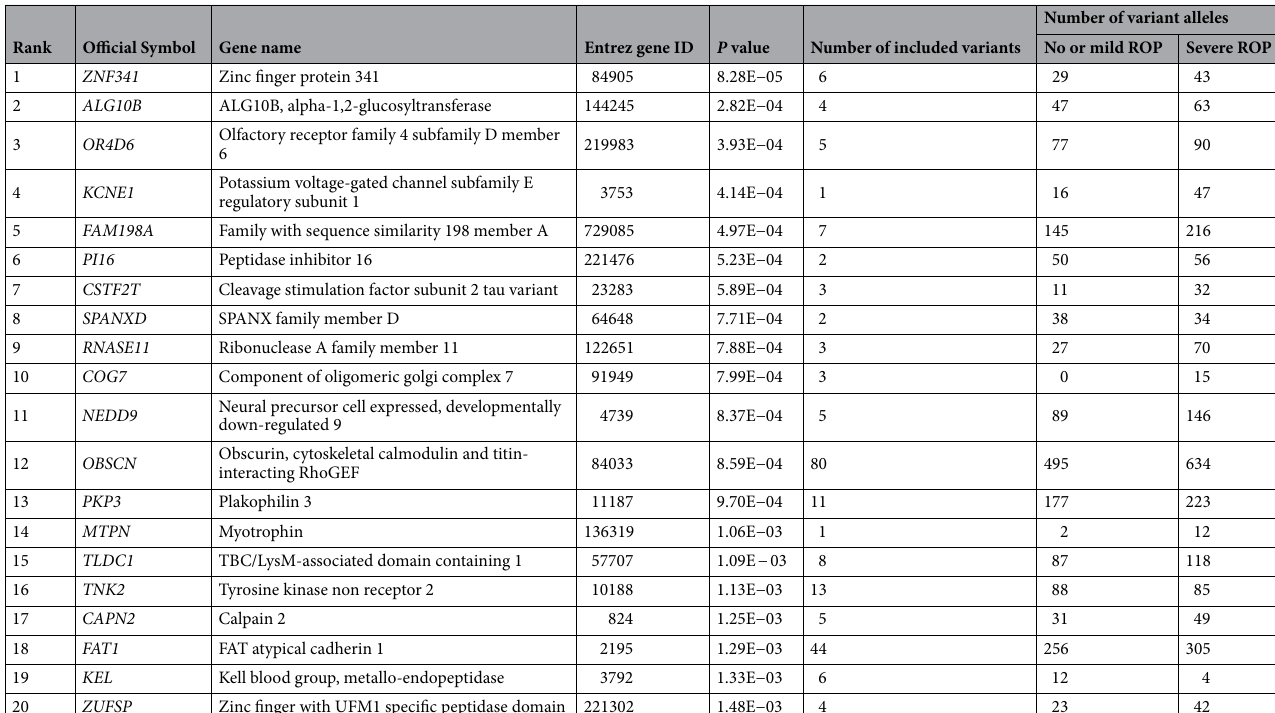
Table 3. Results of common variants analysis: the 20 most strongly associated genes in 100 non-Hispanic Caucasian preterm infants by